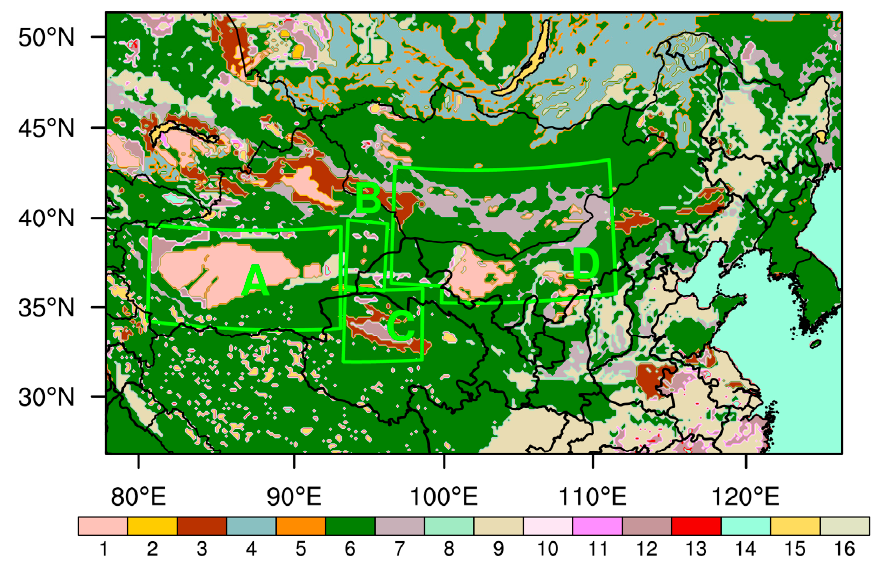
Figure 1. WRF-Chem-generated soil categorizations based on United States Geological Survey (USGS) soil data of the enlarged simulation domain. 1. sand; 2. loamy sand; 3. sandy loam; 4. silt loam; 5. silt; 6. loam; 7. sandy clay loam; 8. silty clay loam; 9. clay loam; 10. sandy clay; 11. silty clay; 12. clay; 13. organic material; 14. water; 15. bedrock; 16. land ice. The green box represents the East Asian desert. A. the Taklimakan Desert; B. the Kumtag Desert; C. the Qaidam Desert; D. the Gobi Desert.